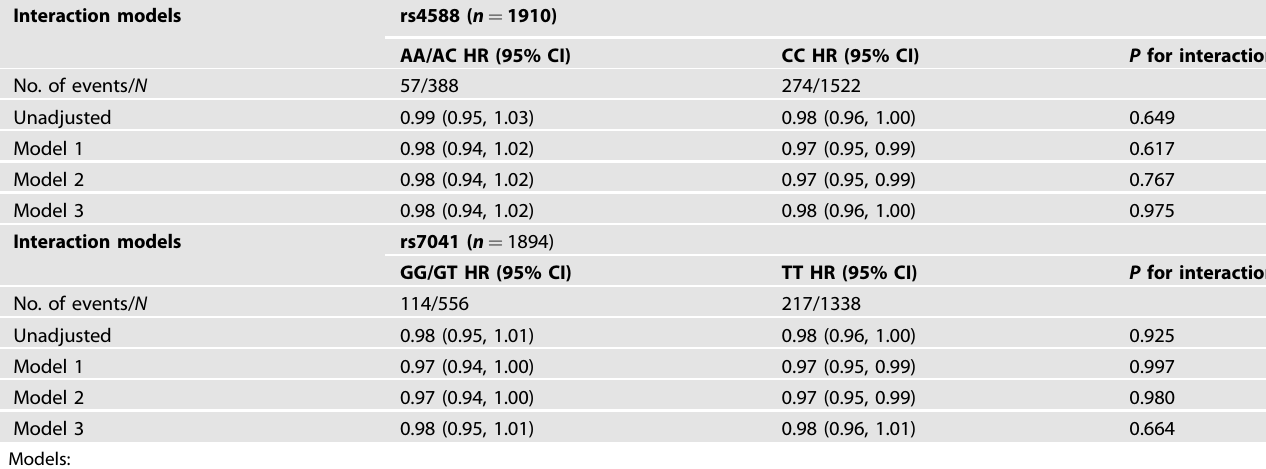
Table 5. Hazard ratios of incident diabetes per 1 ng/ml higher total plasma 25-hydroxyvitamin D according to vitamin-D binding protein genotype (rs7041 and rs4588). Interaction models